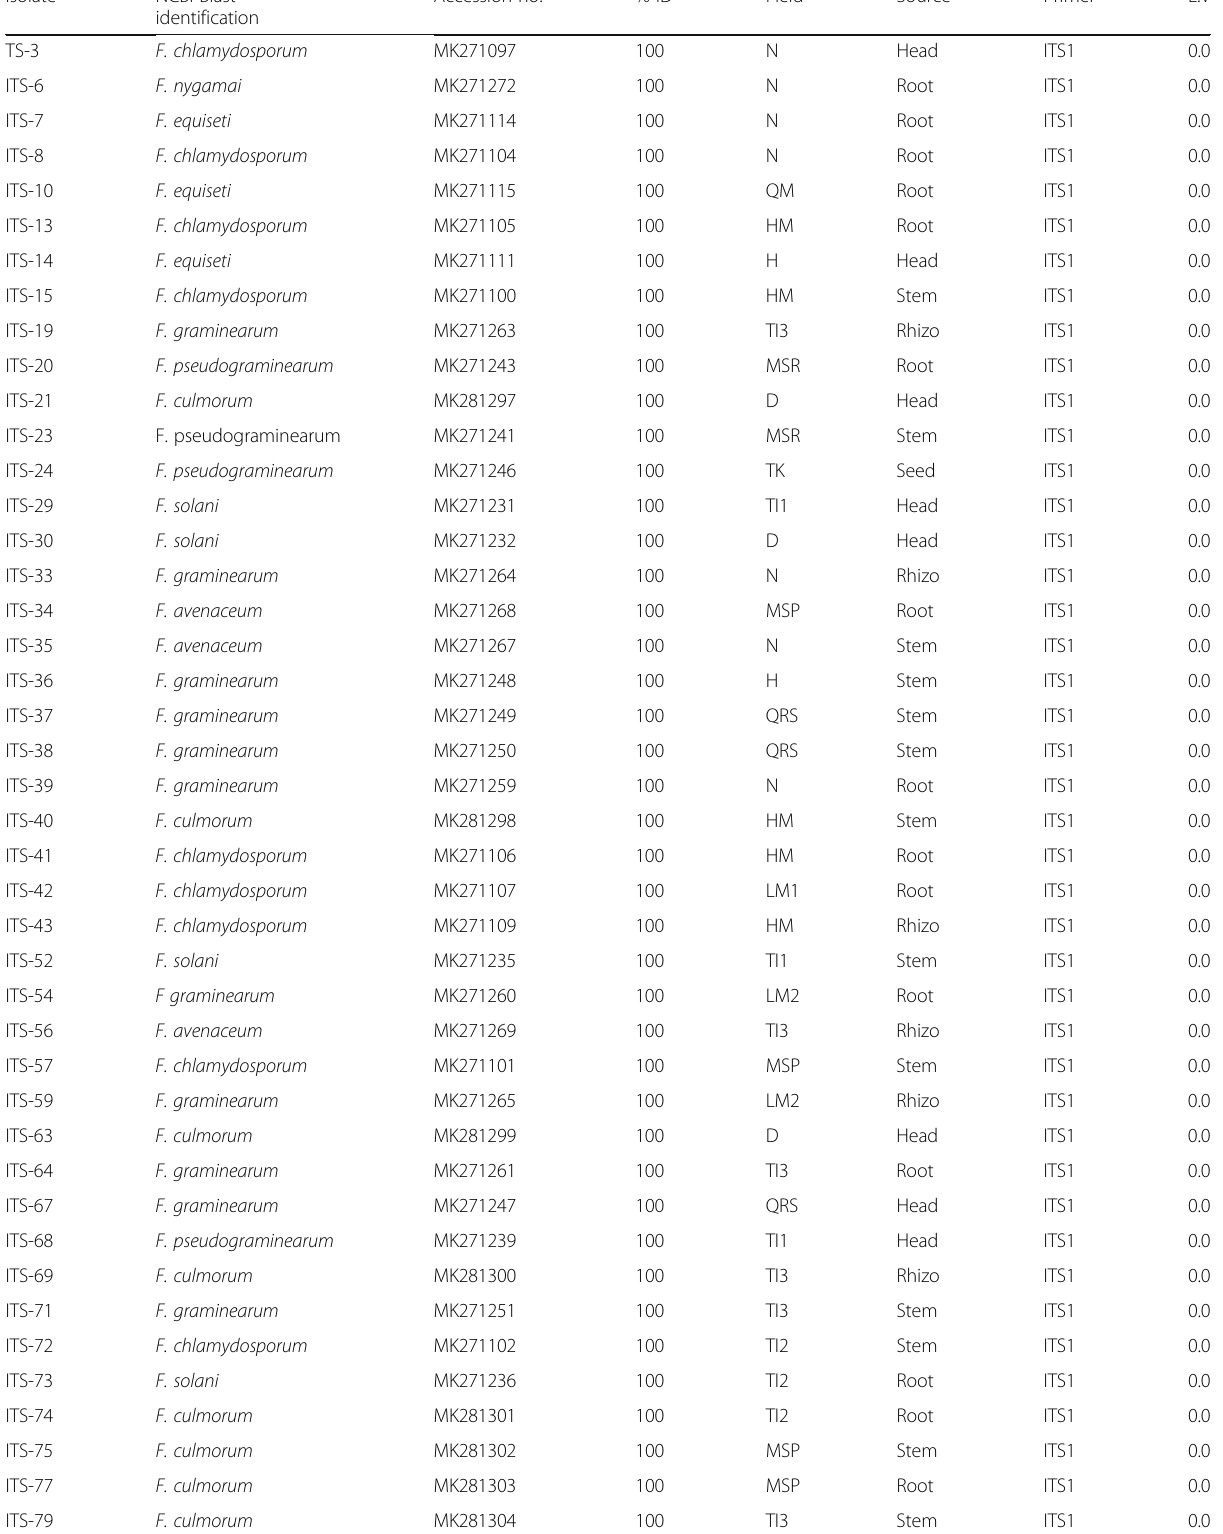
Table 1 Identification of Fusarium taxa isolated from the selected wheat fields based on the sequencing of rDNA ITS1-5.8S-ITS4 region